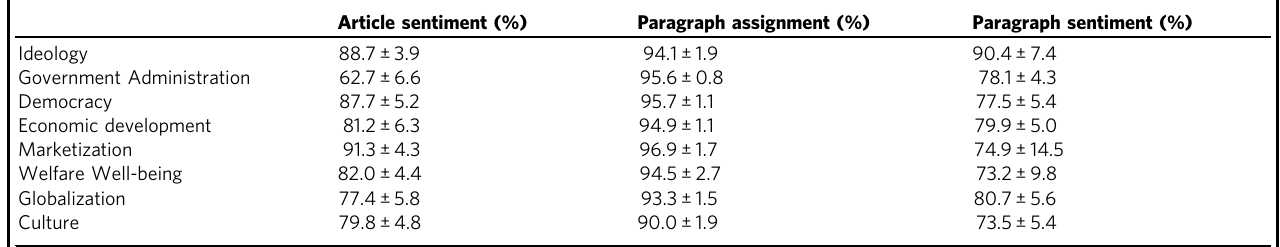
Media article sentiment accuracy is measured by the percentage of correctly labeled articles (positive, negative, neutral/irrelevant) in each topic. Paragraph assignment accuracy is measured by AUC (area under ROC curve) of binary classi fi ons on each paragraph (positive/negative vs. neutral/irrelevant). Paragraph sentiment accuracy is measured by AUC of binary classi fi ons on each paragraph (positive vs.